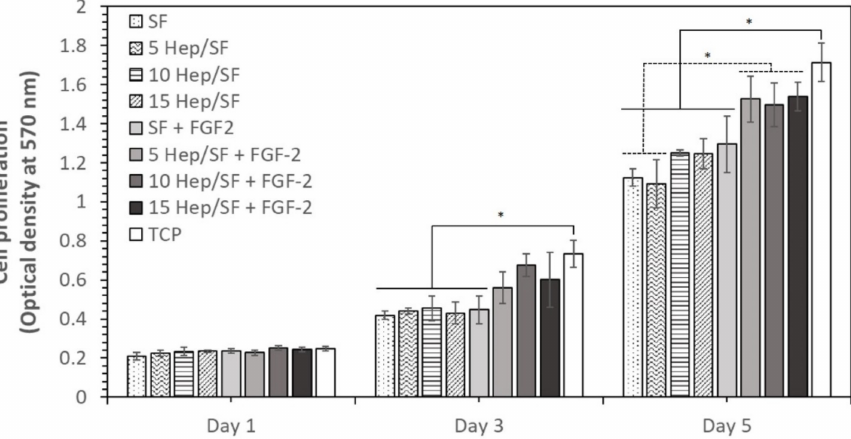
Figure 8. Proliferation of EA.hy926 endothelial cell line cultured on various SF-based samples and control (tissue culture-treated plate, TCP). * p < 0.05 between the